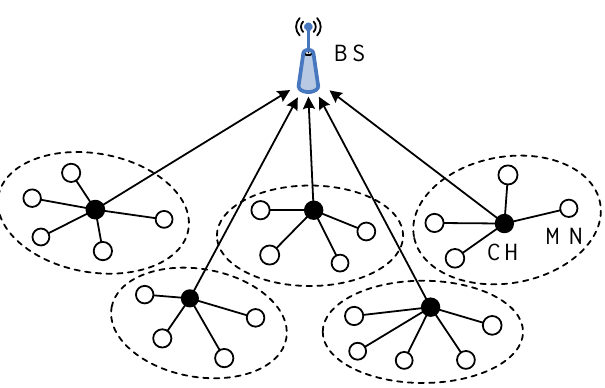
Figure 2. The Basic Topology of